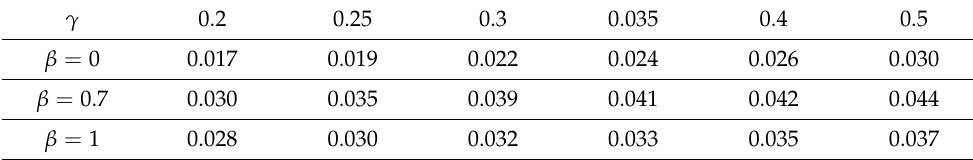
Table 7. Maximum allowable τ for various of γ and β values in Case